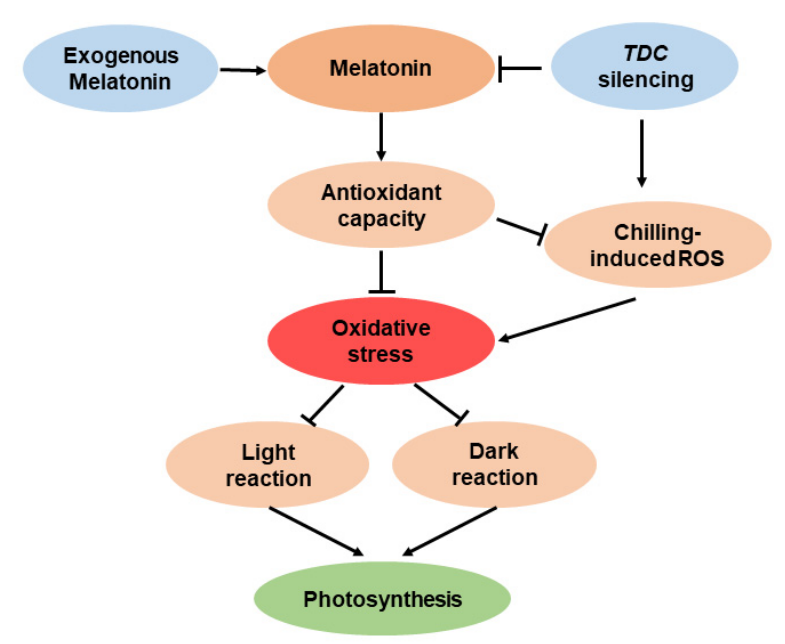
Figure 8. Schematic representation of melatonin in the mitigation of chilling-induced oxidative stress and chilling-induced photosynthesis inhibition in tomato plants. Exogenous melatonin enhances the accumulation of melatonin, which promotes the antioxidant capacity of tomato leaves, thus reducing the chilling-induced oxidative stress. Melatonin-mediated reduction in oxidative stress is advantageous to photosystem II (light reaction) and the Calvin–Benson cycle (dark reaction), thereby favoring photosynthesis under chilling stress. In contrast, silencing TDC suppresses melatonin biosynthesis and thus aggravates chilling-induced oxidative stress, leading to inhibited photosynthesis in tomato plants.